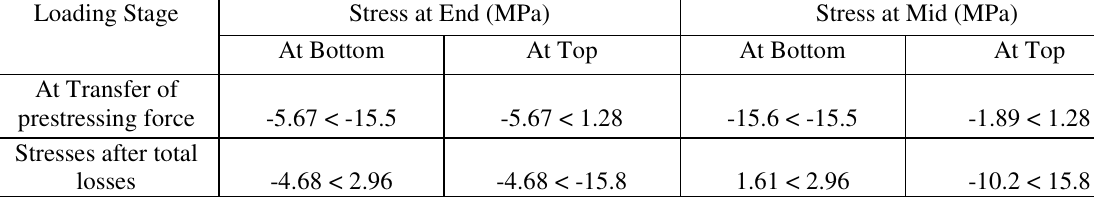
TABLE 4. T-BEAM GIRDER STRESS LIMITS FOR PRESTRESSING